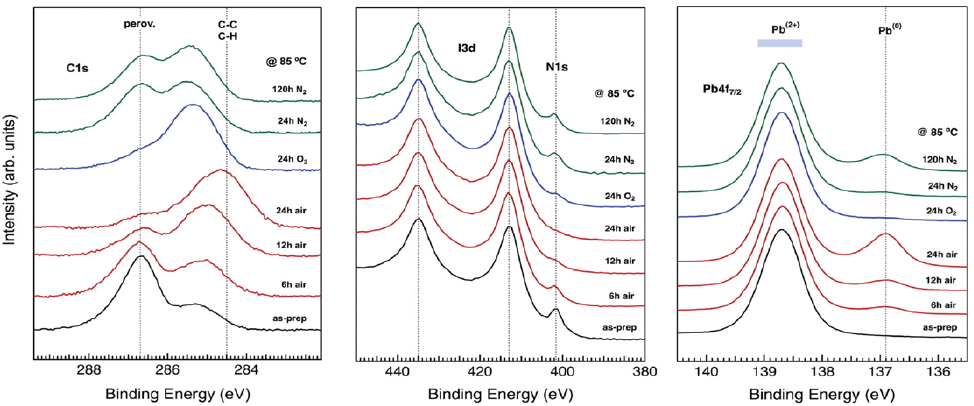
Figure 4. XPS measurements on MAPbI 3 perovskite samples treated at 85 ◦ C for up to 24 h in different atmospheres. Adapted with permission from [58]. Copyright © 2015, WILEY-VCH Verlag GmbH and Co. KGaA,